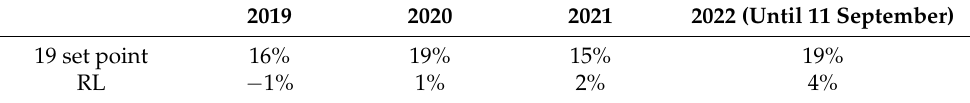
Table 6. Average energy savings from the baseline (21 ◦ C) of the buildings per simulation